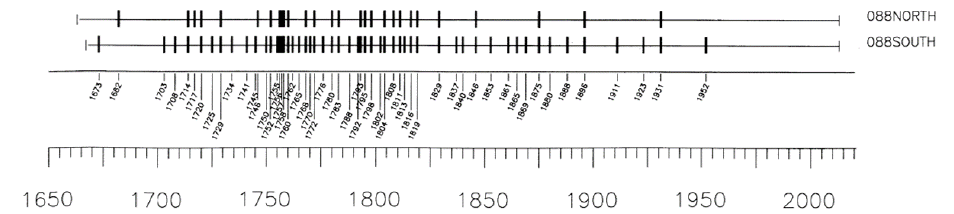
Figure 5. Composite fire ‐ scar history at SGL 088 separated by north and south aspects. For